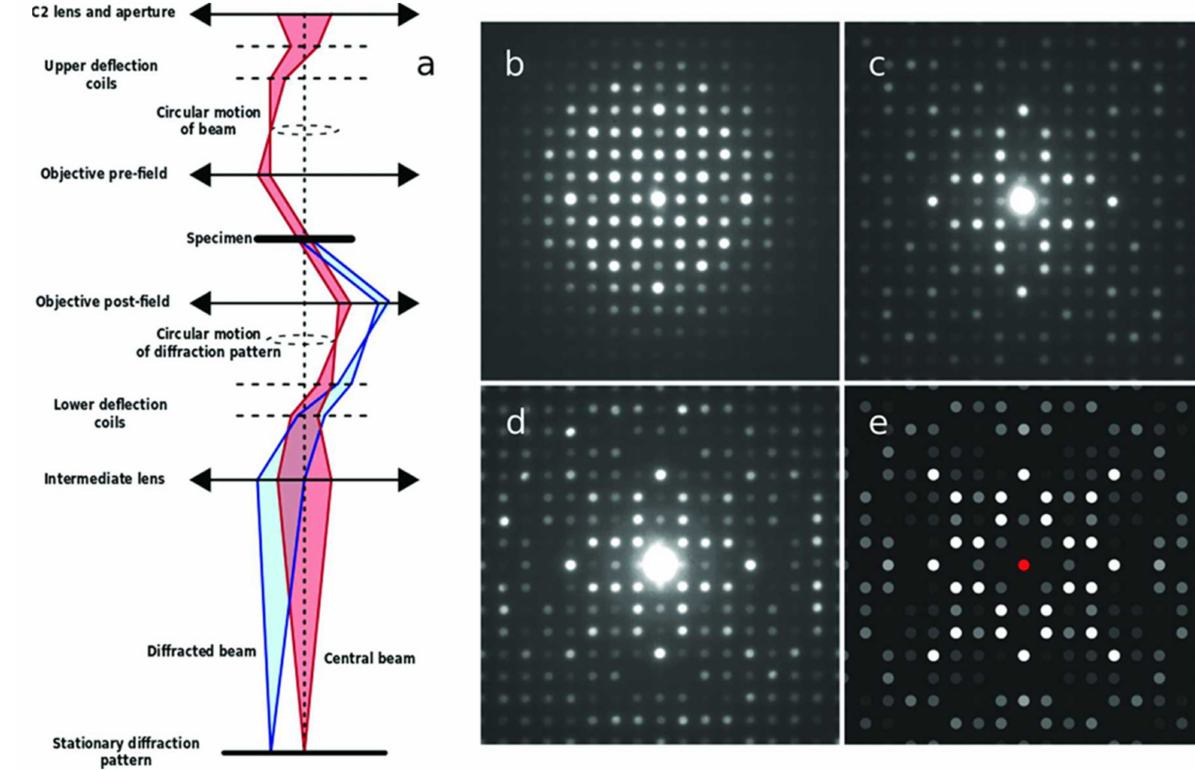
Figure 20. ( a ) A schematic ray diagram for precession electron diffraction (PED), illustrating the rocking/de-rocking action of the beam before and after the specimen. ( b – e ) Illustrations of how precession alters the recorded diffracted intensities, here from the [001] zone axis of Er 2 Ge 2 O 7 : ( b ) without precession, ( c ) with a precession angle of 20 mrad, ( d ) with a precession angle of 47mrad. The pattern of diffracted intensities seen in ( d ) is similar to that seen in the kinematic simulation shown in part ( e ). Figure 20 reprinted from [174] under the terms of the Creative Commons CC BY